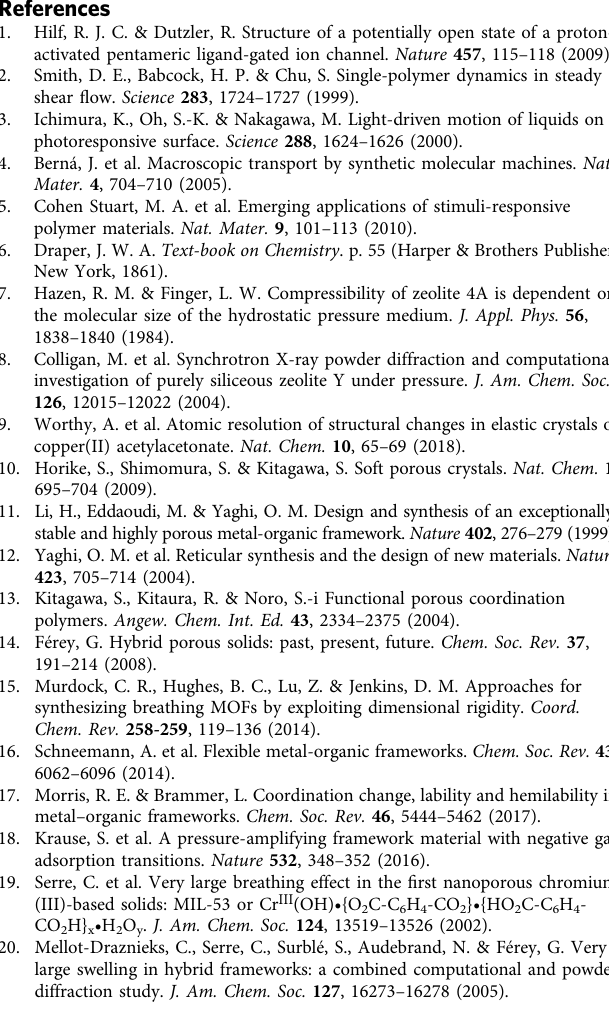
(which is proportional to the number of LPE fabrication cycles, as well